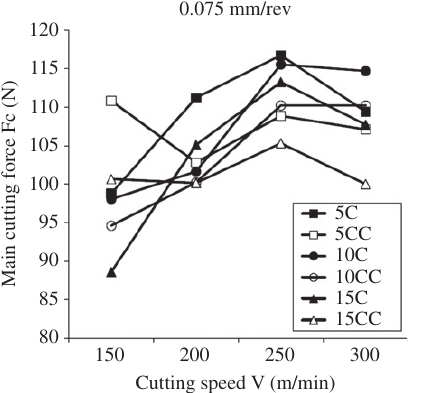
Figure 8 Changes in Fc in 5 % , 10 % and 15 % MgO reinforced MMC specimens by cutting speed (C and CC cutting tools; 0.225 mm/rpm feed rate).